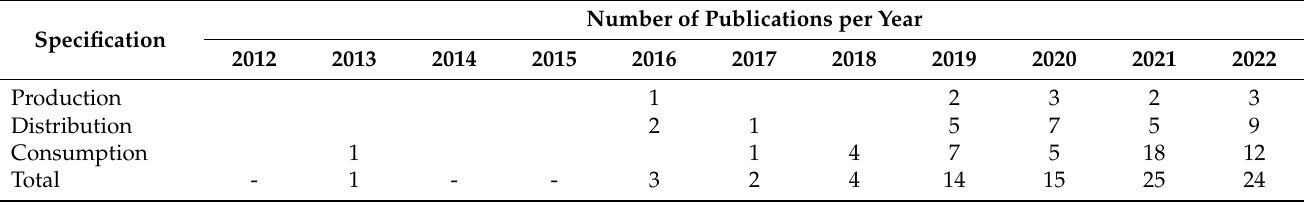
Table 8. Number of publications per year in each sector 1